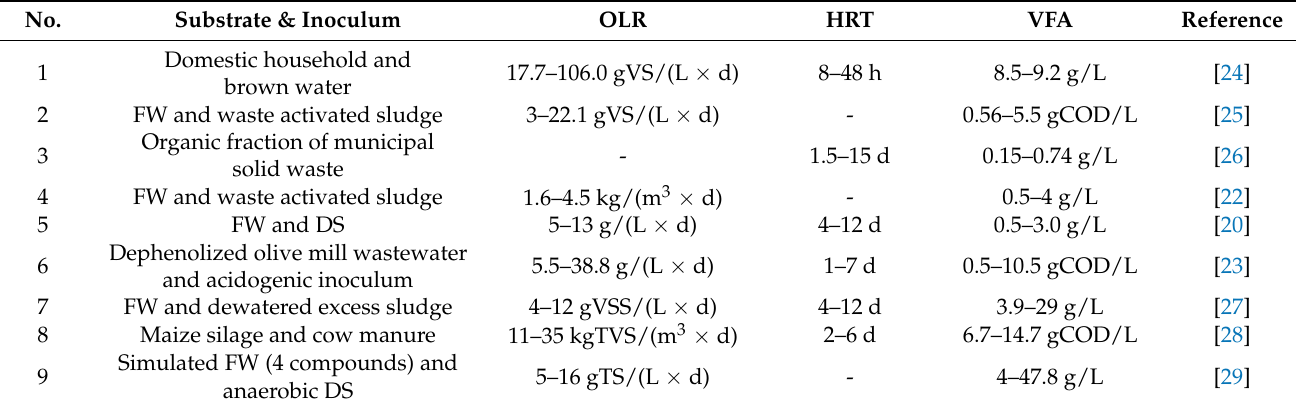
Table 1. Values of OLRs and HRTs used in different DF